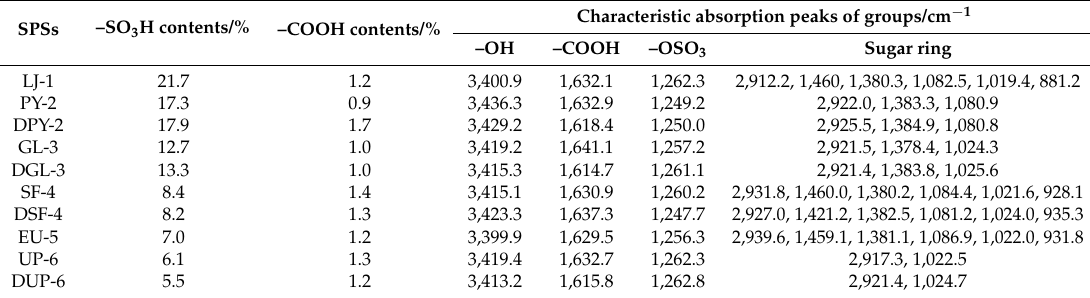
Figure 2. FT-IR spectra of representative seaweed polysaccharide degraded Sargassum -4. Table 3. FT-IR characteristic absorption peaks of native and degraded seaweed polysaccharides.